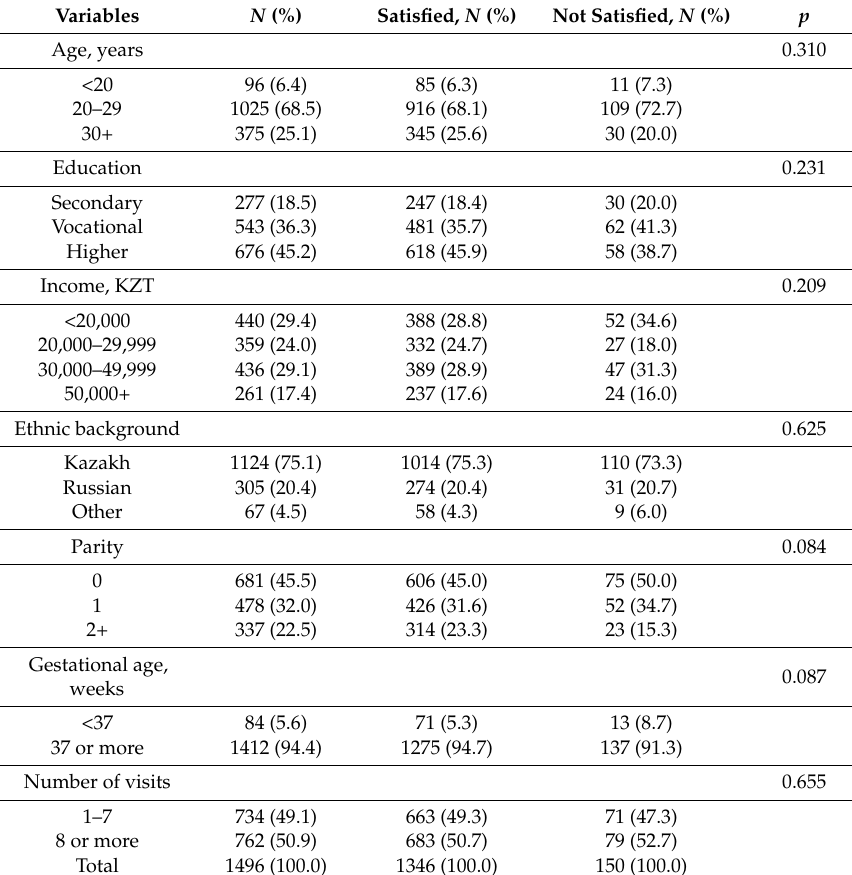
Table 1. Bivariate associations between satisfaction by antenatal care and maternal socio-demographic and obstetric